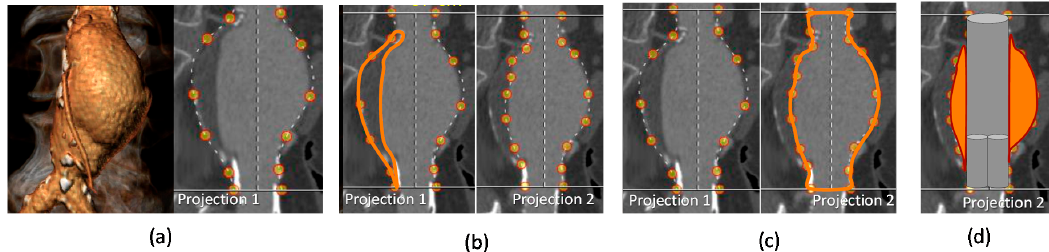
Figure 7. Example of consecutive steps for aneurysm volumes computation when using 3Mensio, based on manual selection of fiduciary markers along the vessel profile in two different planar projections: selection for abdominal aortic aneurysm (AAA) Total volume ( a ), AAA thrombus and lumen volumes ( b , c ). Calculation of endoluminal Free Volume (FV) available for Sac Embolization (SE) (orange area in ( d )) is not directly provided by the software but has to be performed offline.